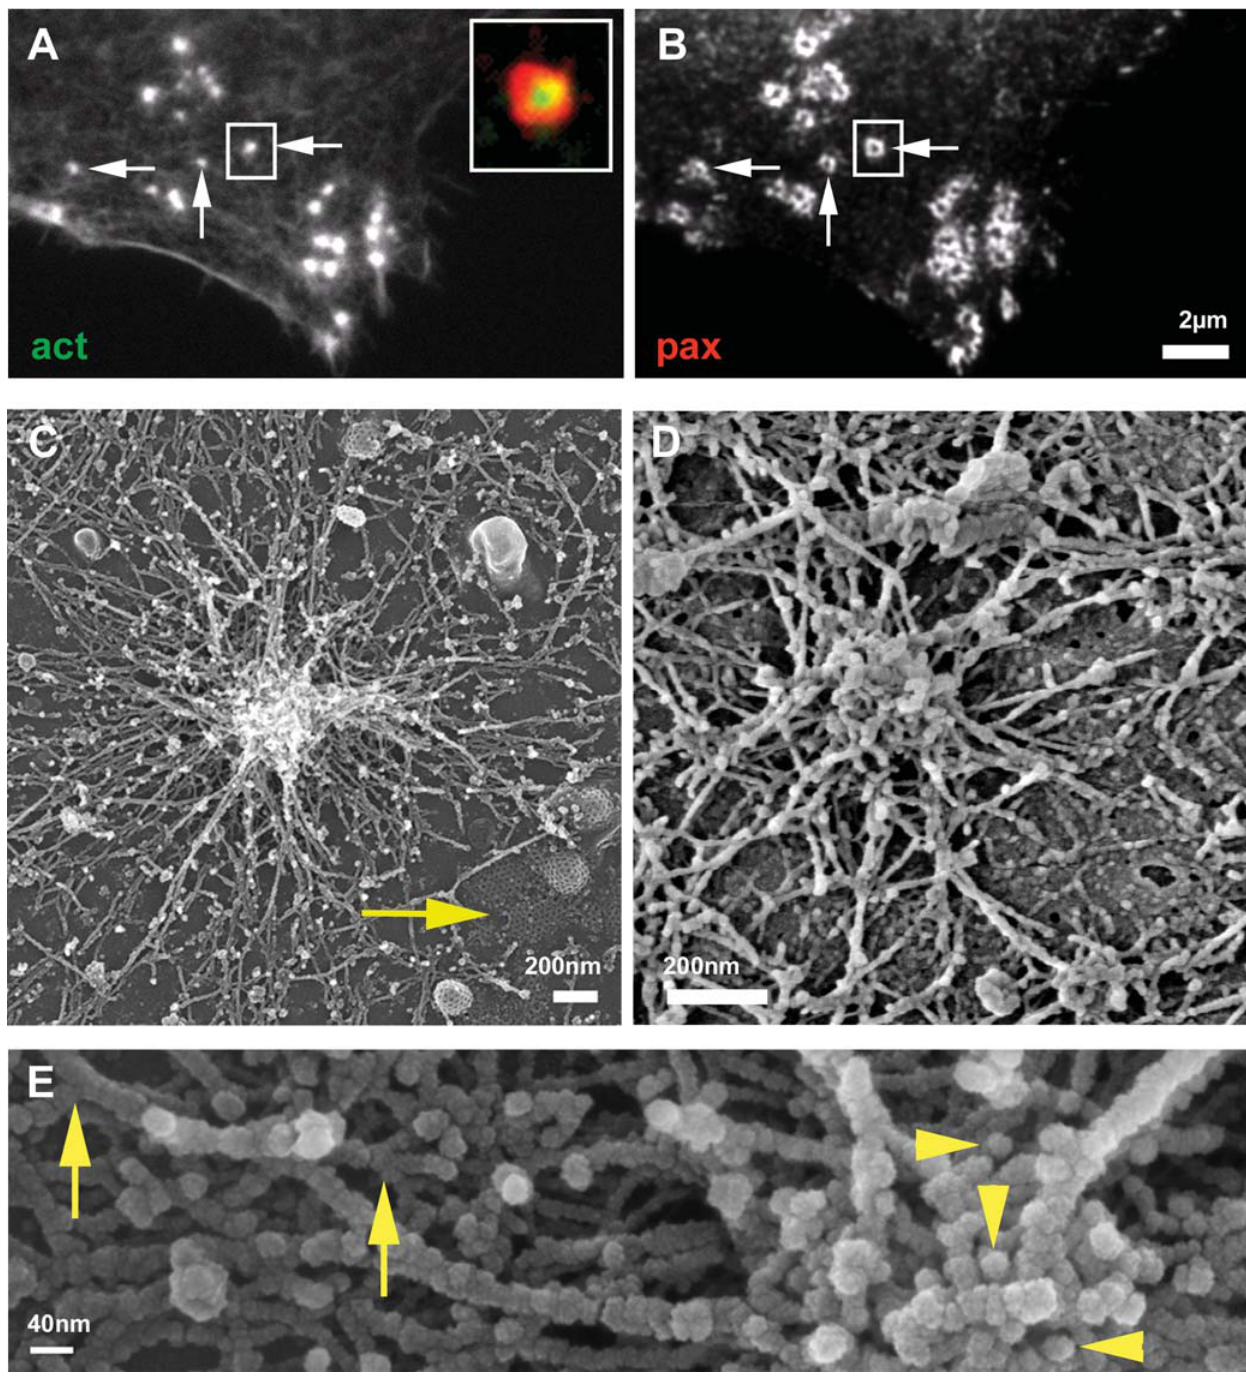
Figure 1. Individual podosome. Intact osteoclast (A,B) or ventral membranes (C–E) fixed and stained for actin (A) or paxillin (B ) or prepared for HR- SEM (C, D, E). Individual podosomes (A, B arrows) are isolated from nearby structures and show no overlap with neighboring podosomes in paxillin staining (B, arrow). The insert in (A) shows a merged image of actin/paxillin staining. (C) An isolated podosome showing a dense actin core at the center of the podosome and actin fibers radiating from it and interacting with the ventral membrane. Note membrane-associated clathrin pits (C, arrow) testimony of the excellent preservation of the sample. (D) Structures very similar to (C) are detected in osteoclasts plated on bone slices. (E) Higher magnification of a podosome shows tightly packed actin fibers at the actin core, many of which are almost perpendicular to the substrate (arrowhead). The occasionally observed concavity at the peak of the podosome (D,E) may reflect the underlying membrane invagination related to dynamin (16). The actin fibers radiating from the core show branching points (arrows).